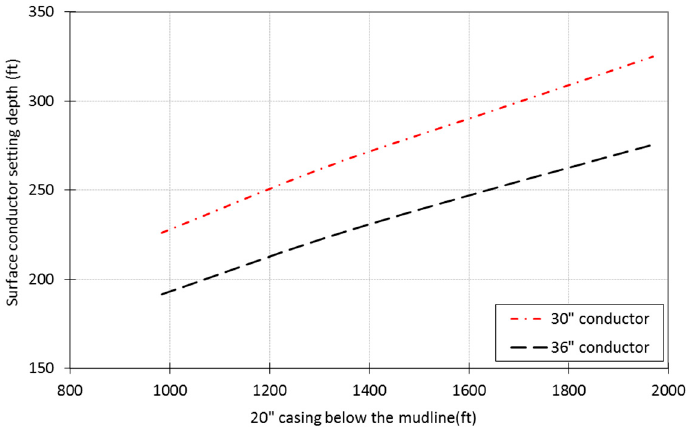
Figure 10. The relationship between 20” casing’s design depth and surface conductor setting depth (set-up time is two days).